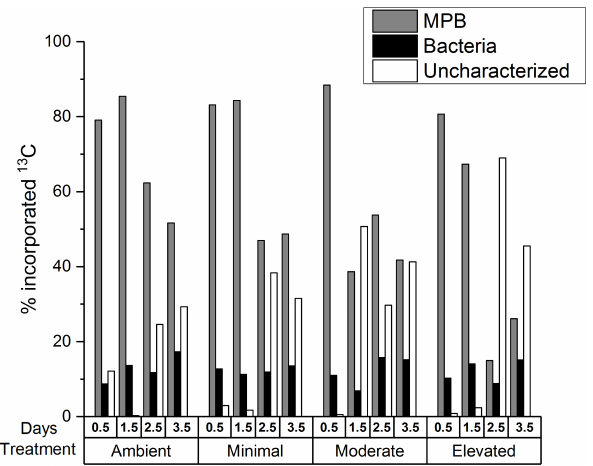
Figure 3. Excess 13 C incorporation into microphytobenthos, bac- teria, and uncharacterized OC as a percentage of 13 C contained in sediment OC in 0–10cm. There are no error bars as PLFAs were analyzed for only one replicate sample from each time period.